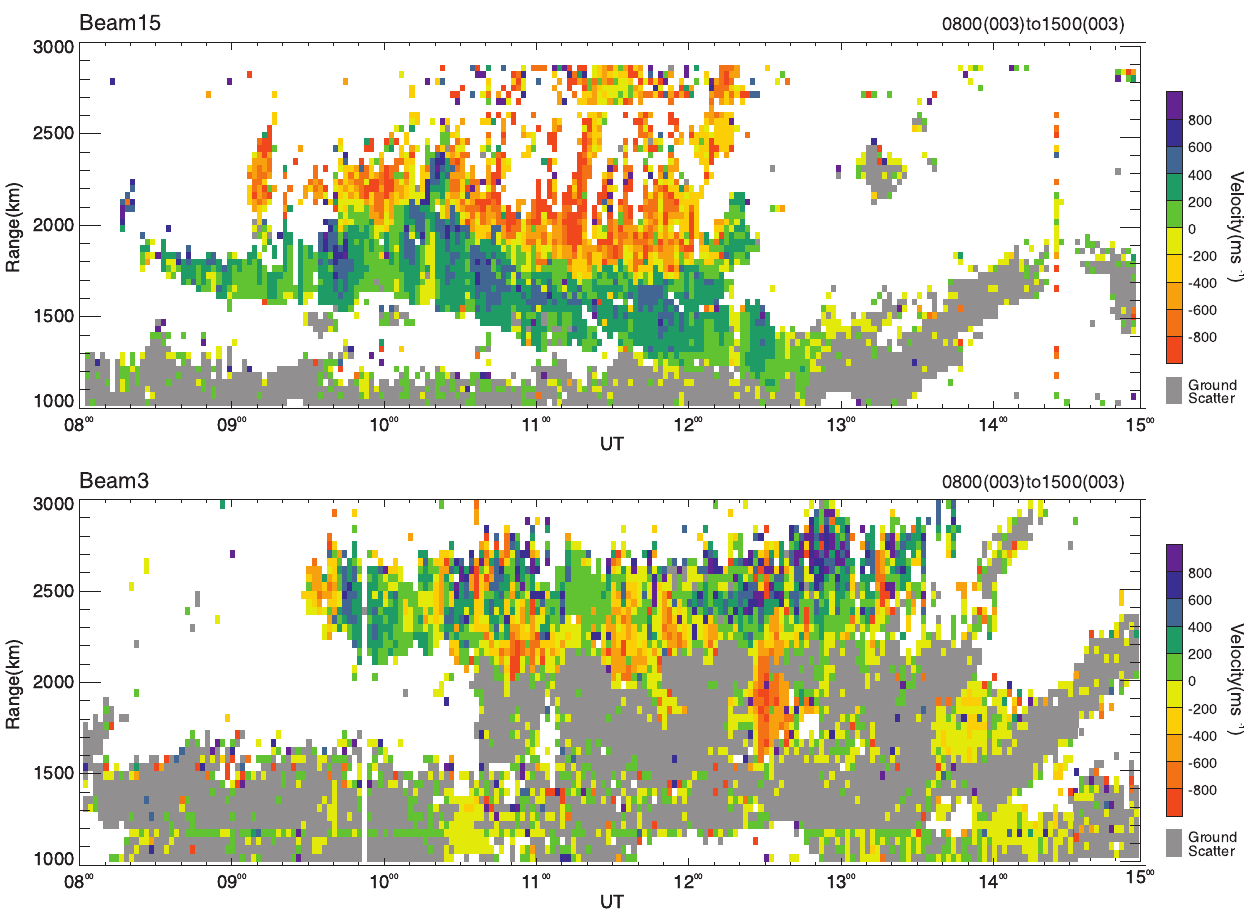
stripes seen in the data from beam 15 ( top ). Periodic velocity fluctuations also exist in the beam 3 data ( bottom ), but they are not so